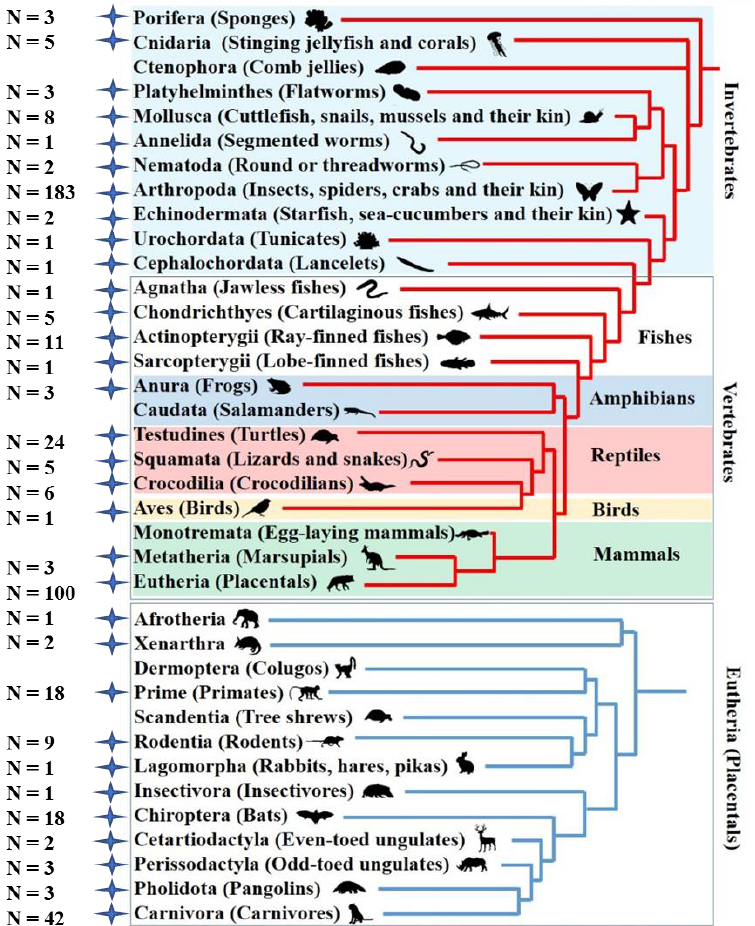
Figure 3. Distribution of Tigger transposons in eukaryotes. Blue stars show Tigger elements detected in the branches, and the numbers indicate the number of species possessing Tigger elements in each branch.